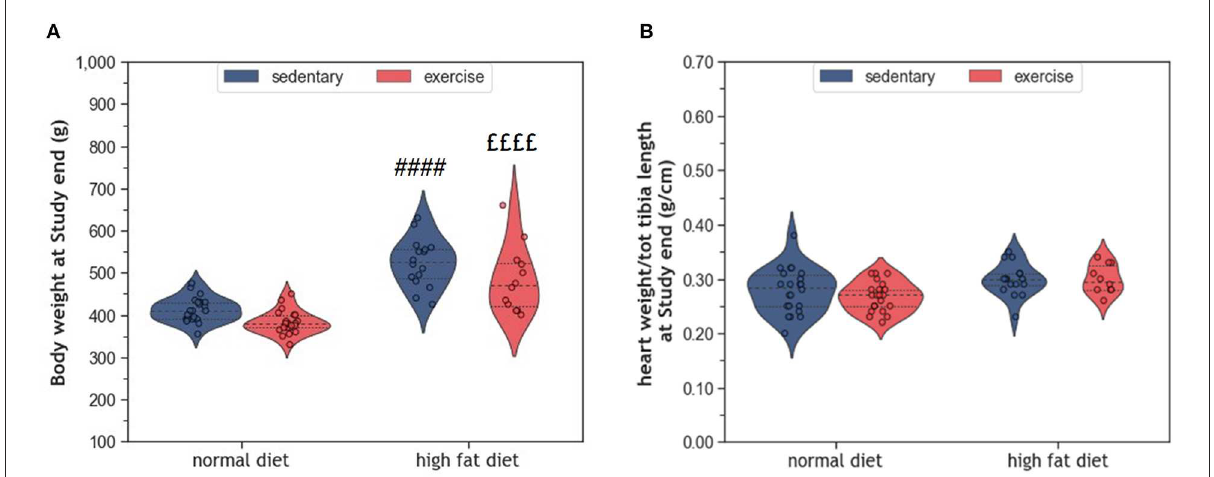
FIGURE1 (A) Violin plots showing the distribution of body weight and (B) Normalized heart weight; the dashed line represents the group median whereas the dotted lines show the 25th − 75th interquartile range. The circles indicate the scatter of the data. Group differences have been calculated by two-way ANOVA with Sidak post-hoc tests for multiple comparisons. p- values are only shown for pre-specified group comparisons. #### p < 0.0001 compared to the sedentary normal diet control group; ££££ p < 0.0001 compared to the exercise normal diet